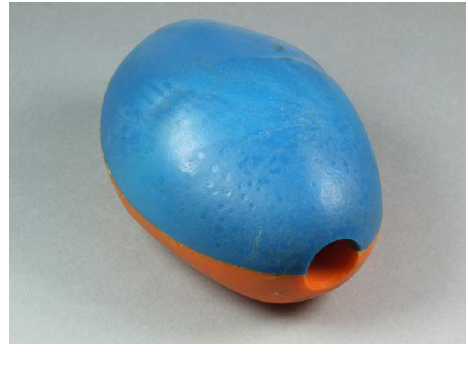
Figure 4. TuberLog acceleration measuring